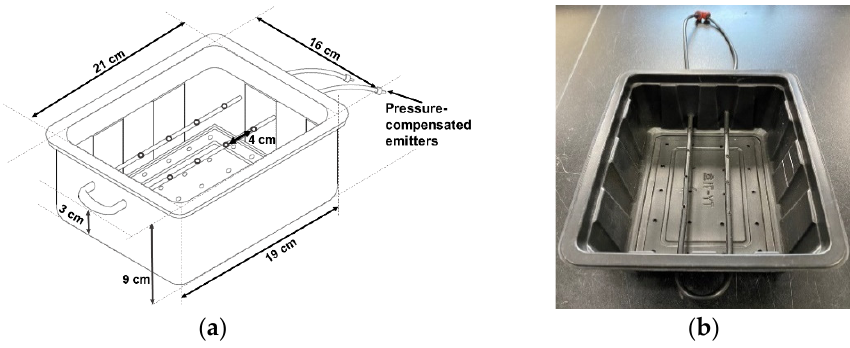
Figure 1. Customized plastic container used for cutting propagation. ( a ) Diagram of the container; ( b ) Actual container (L × W × H: 21 × 16.3 × 9 cm, bottom length: 19 cm; 2 L volume) used for subsurface drip irrigation in the current experiment. Irrigation tubing with holes at 4 cm intervals was connected to two pressure-compensated emitters (2 L·h − 1 ; Netafim). Two lines of the irrigation tubing were located at a 3 cm height from the bottom of the container to provide moisture evenly near the base of the area with cuttings.